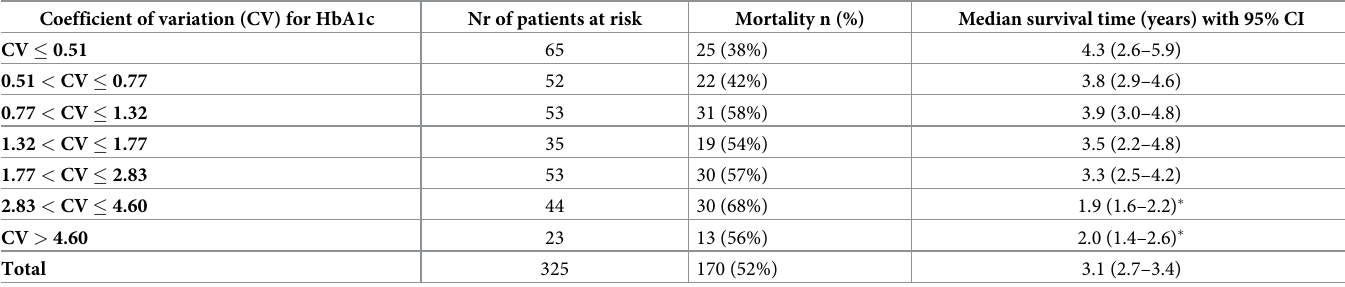
included in the analyses of HbA1c variability. 49% of the patients had 2 measurements and 51% had between 3 and 12 measurements. We showed that high HbA1c variability, as a mea- sure of long-term glycemic variability, was associated with a markedly increased risk of all- cause mortality in diabetic patients with ESRD and PD treatment. The mean age of our population was 66 years, which is almost similar to the general popula- tion with ESRD and dialysis treatment. The mean HbA1c value was 6.8%, which indicates that most of the diabetic patients had adequate long-term glycemic control. Furthermore, the patients mostly had acceptable BP during the study (SBP 137 ± 17 mmHg, DBP 76 ± 9mmHg). The mean serum albumin was also under adequate control (31 ± 5 g/L). As a result, our popula- tion was mostly relevant in terms of the aims of the present study. Previous studies have assessed the relationship between the mean HbA1c level and the risk of CVD or mortality in diabetic patients with ESRD and dialysis [20, 21]. The results are